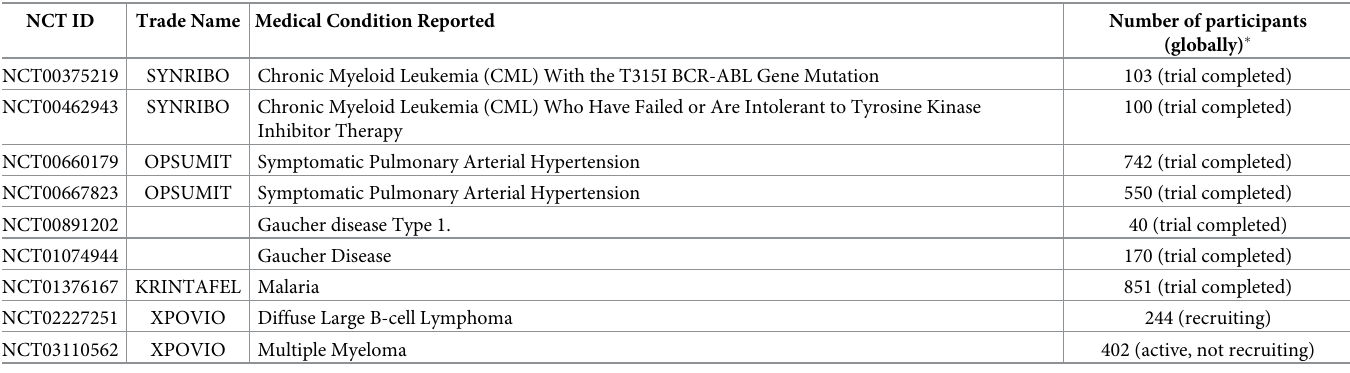
Table 1. Details of the 9 OD trials run in